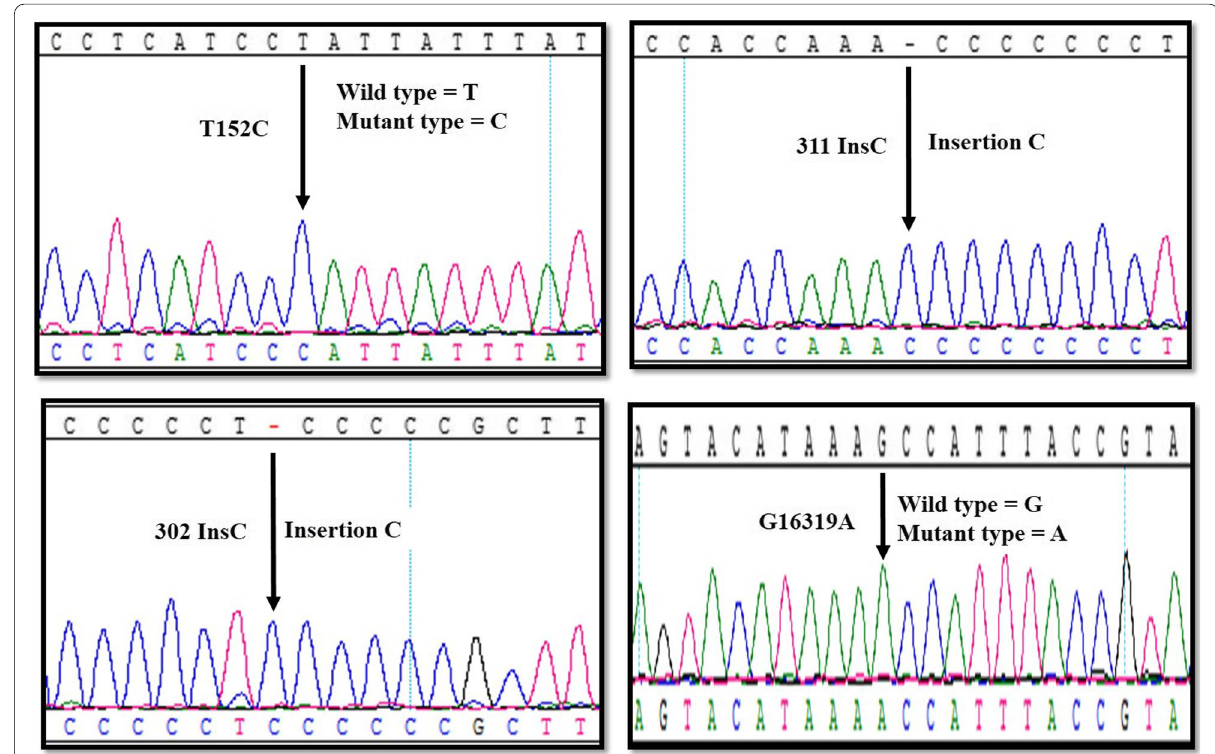
Fig. 3 Chromatogram showing synonymous variation at 152, 311,302, and 16319 base